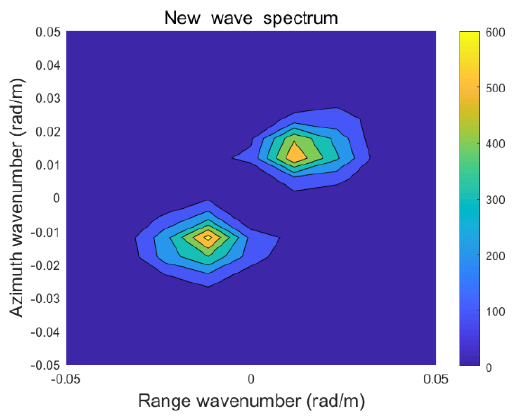
Figure 6. The wave spectrum after splicing.